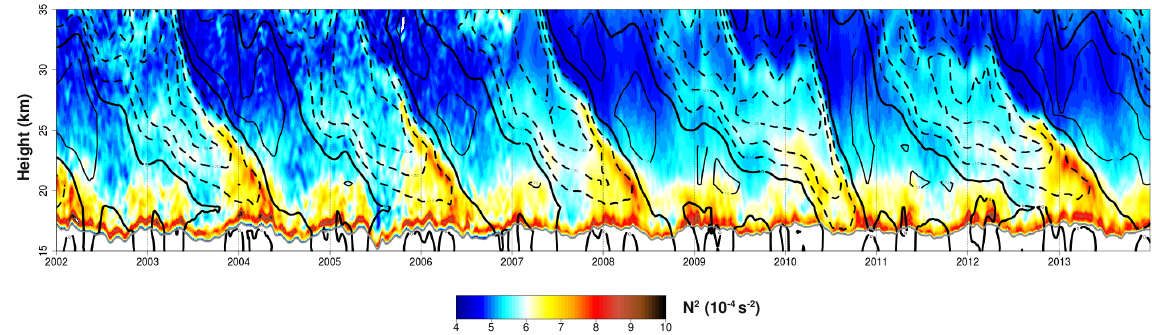
Figure 1. Daily evolution of the tropopause-based, equatorial (5 ◦ S–5 ◦ N) zonal mean N 2 vertical profile between 2002 and 2013 (colors). The years 2002–2006 are from CHAMP plus GRACE GPS-RO profiles; 2007–2013 are from COSMIC. The grey line denotes the tropopause height (TP z ). Thin black contours denote positive (westerly) mean zonal wind, with a thicker contour for the zero line, dashed contours for negative (easterly) winds and a 10ms − 1 separation. To improve visibility, each day shows the running mean N 2 profile and TP z of ± 7 days. In the case of the winds, the running mean is made for ± 15